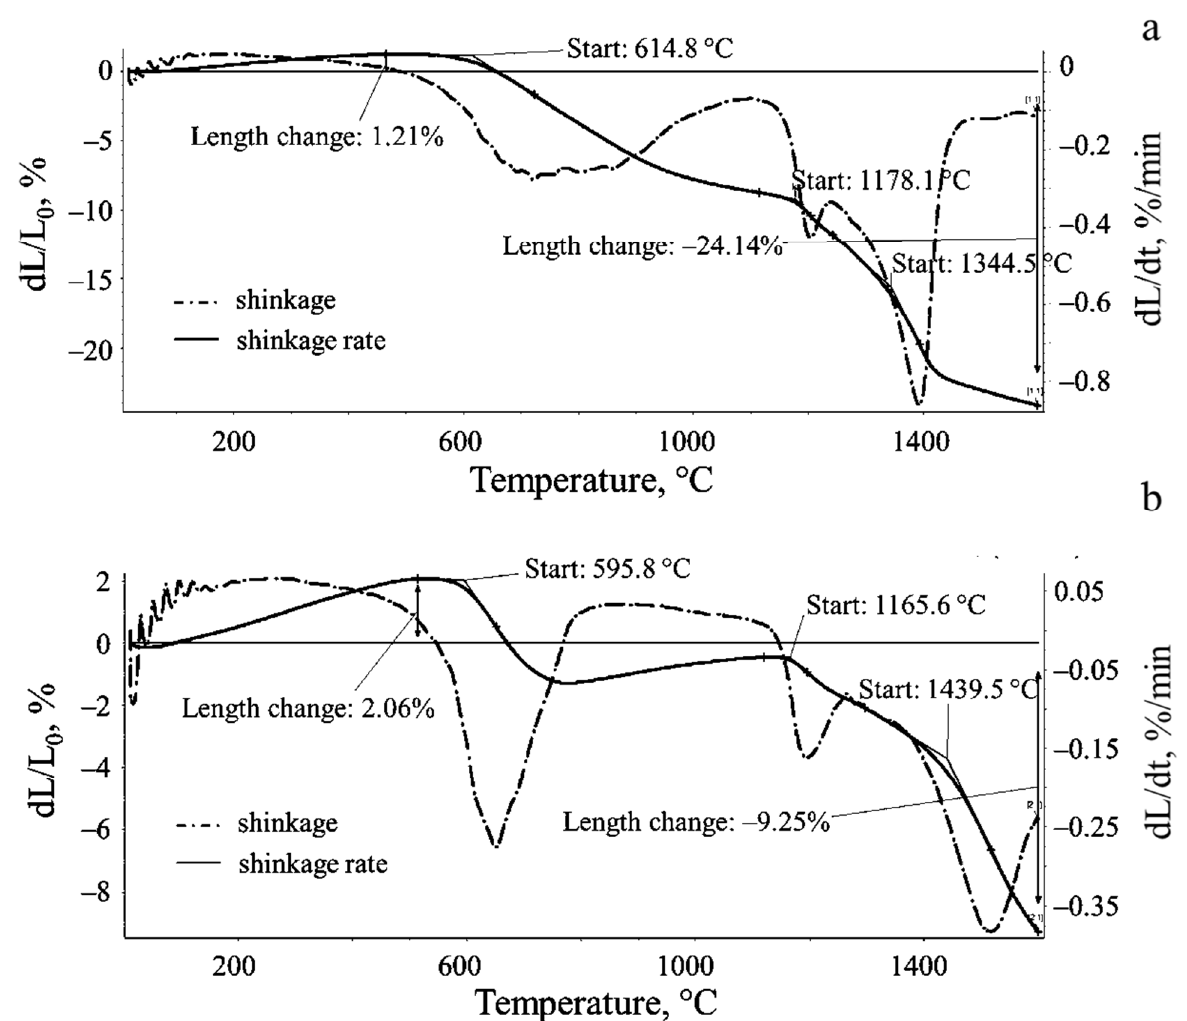
Figure 10. The shrink and shrink rate curves for the graphene-zirconia composite ( a ) and the single nano-zirconia ( b ).